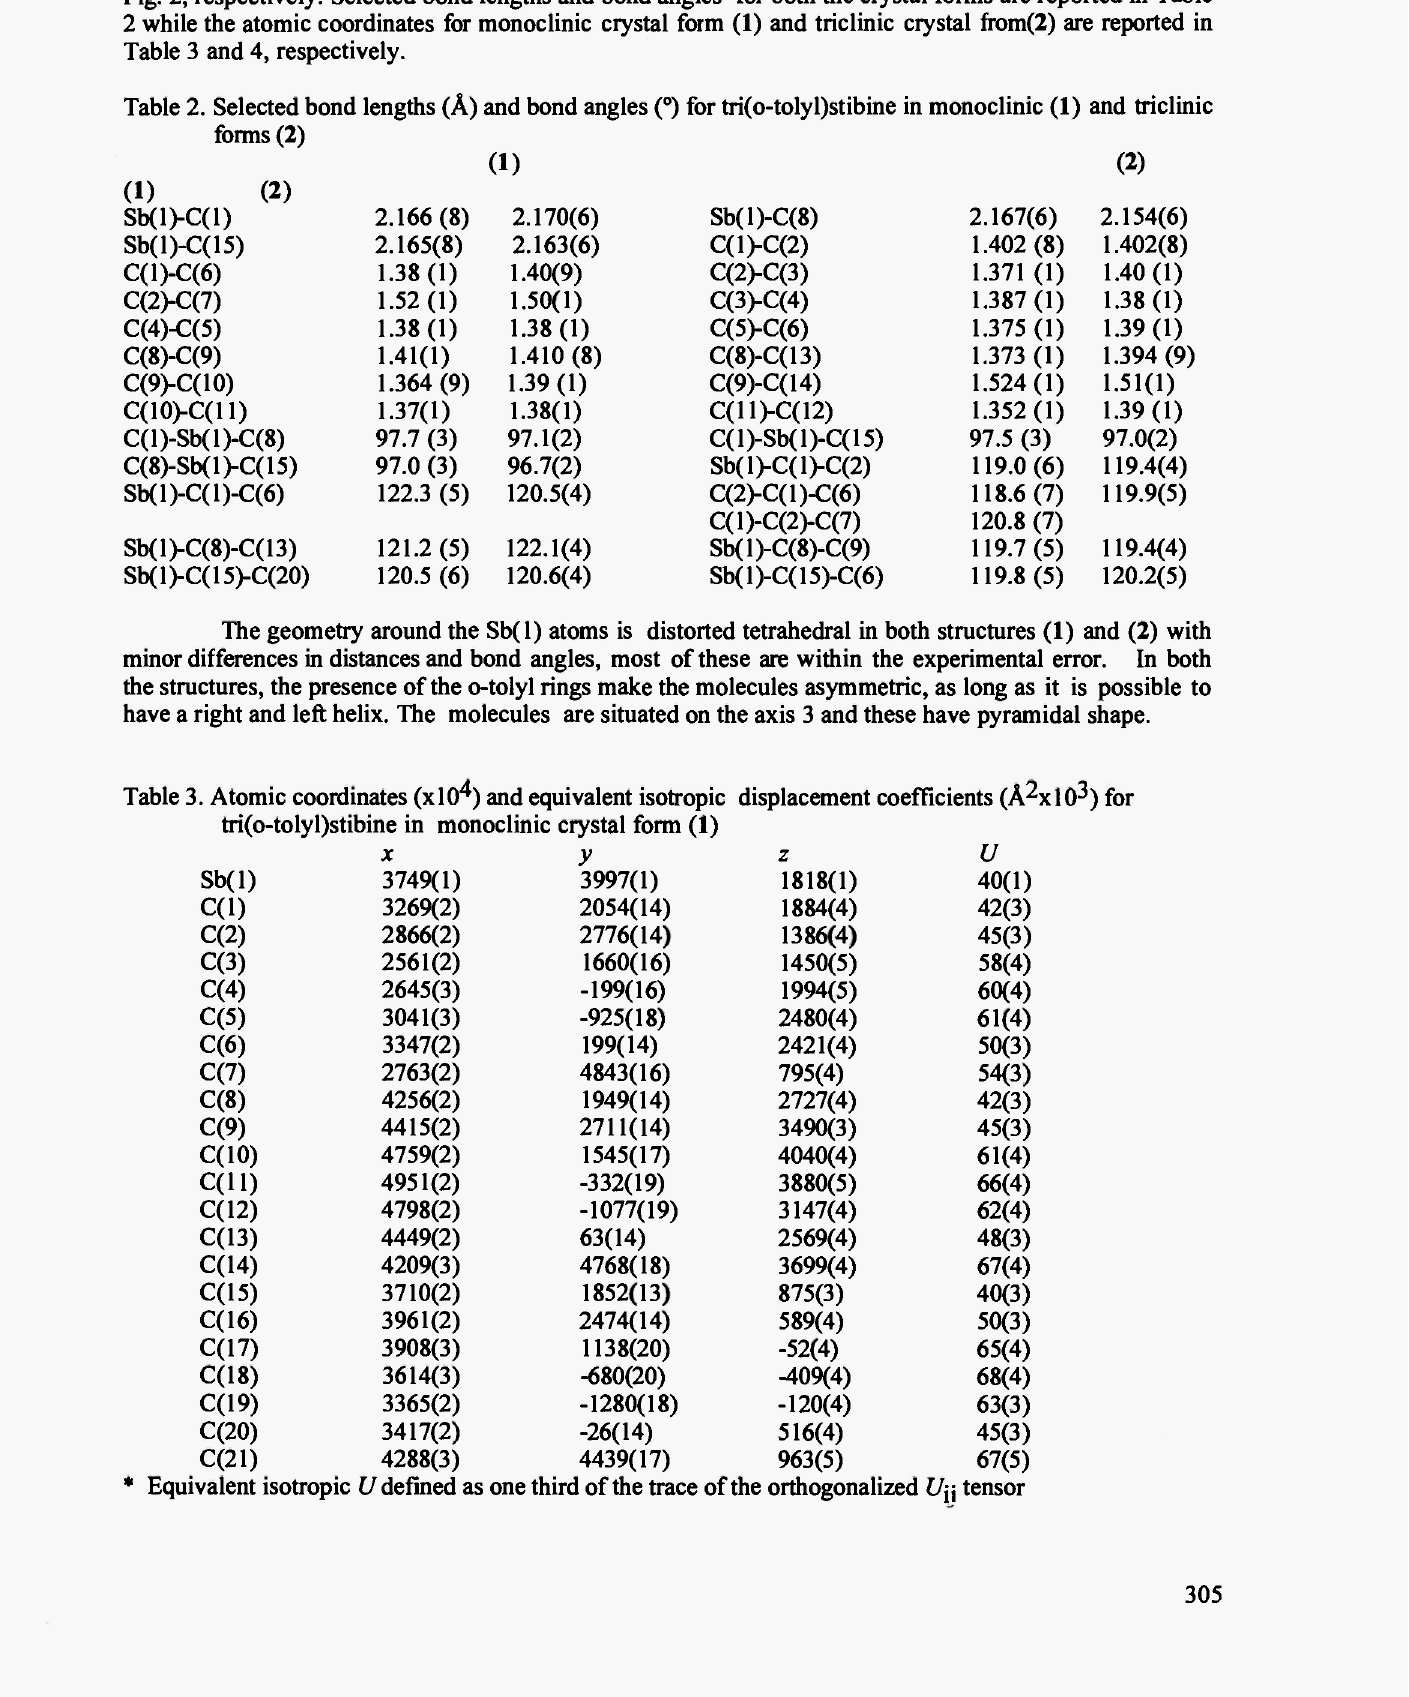
Table 2. Selected bond lengths (Ä) and bond angles (°) for tri(o-tolyl)stibine in monoclinic (1) and triclinic forms (2)